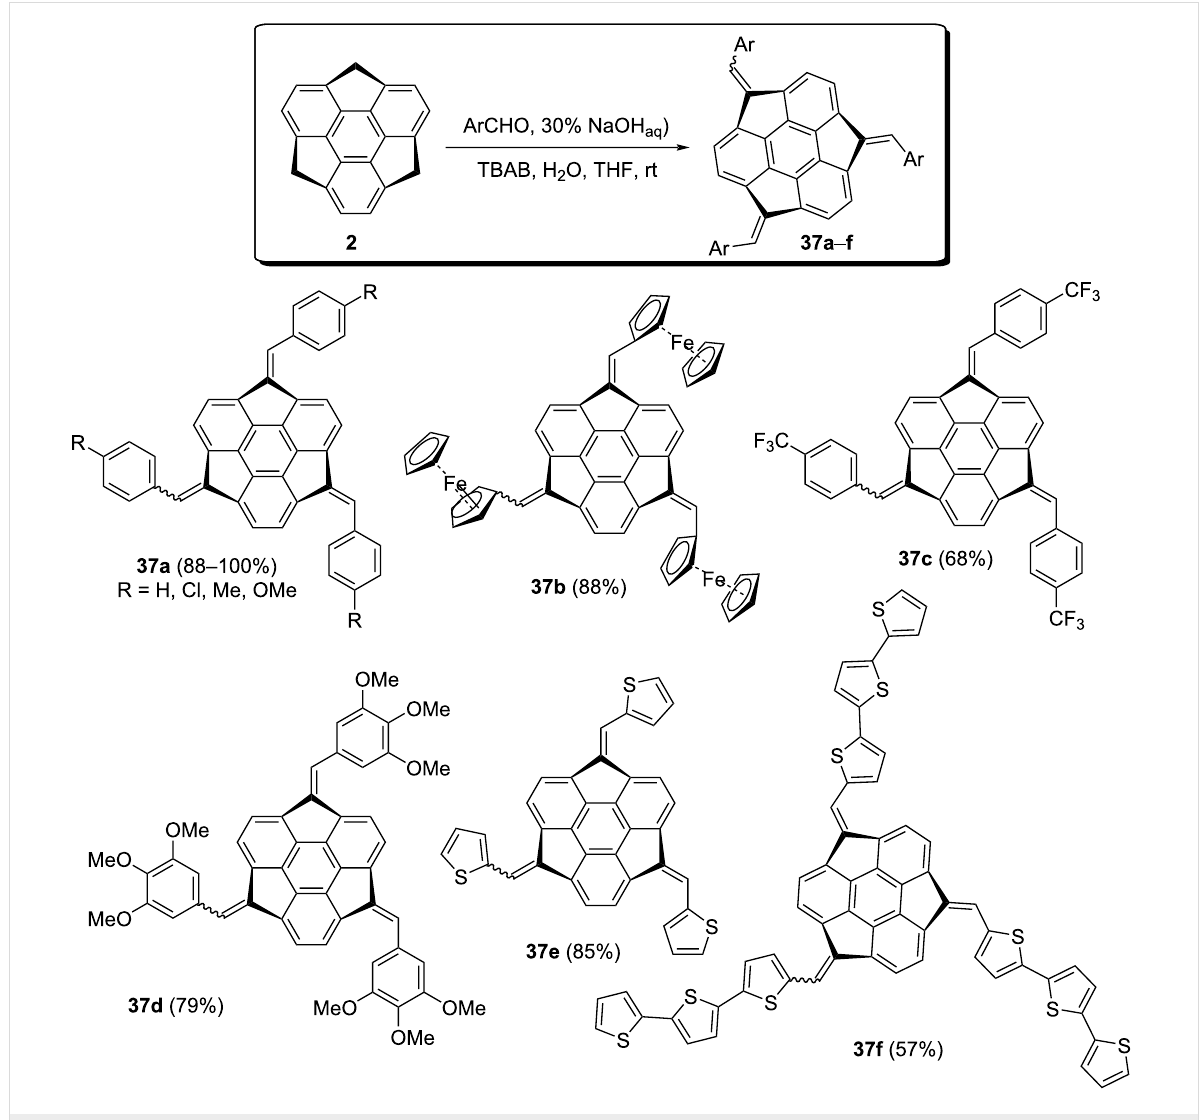
Scheme 6: Synthesis of bowl-shaped π -extended sumanene derivatives 37a–f .